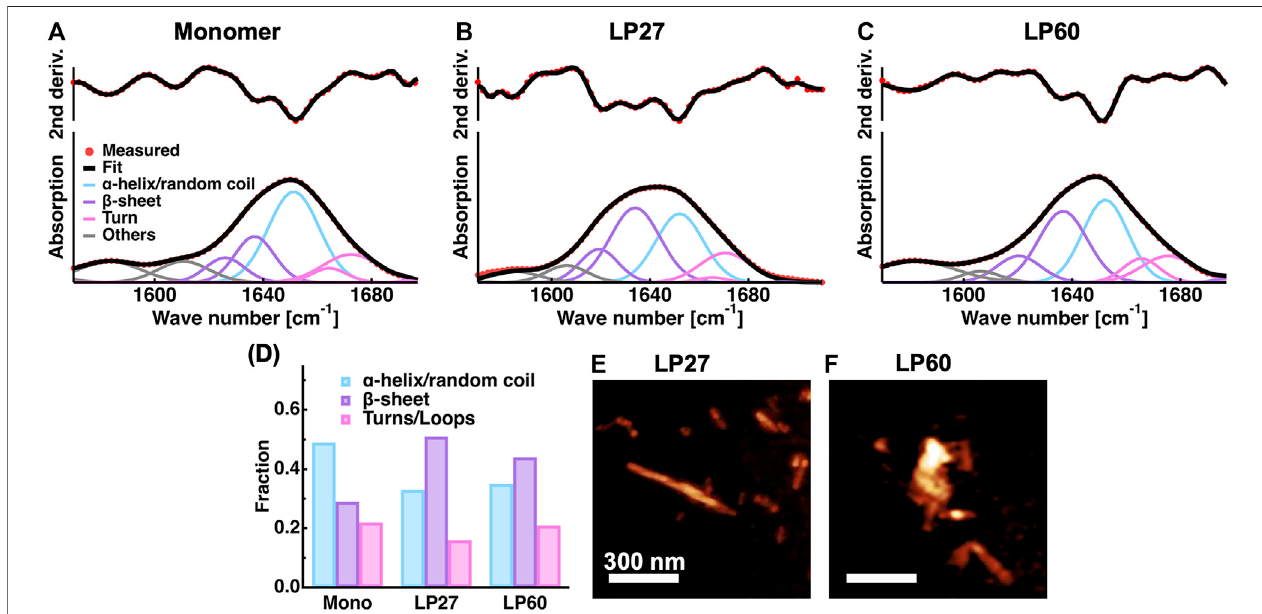
FIGURE3| Samplecharacterization. (A – C) :ATR-FTIRspectraofHEWL monomers (A) andHEWL polymorphsformed at pH2.7[LP27; (B) ] andat pH6.0 [LP60; (C) ].Thesecondderivativesofthespectraandthe fi ttingresultsarealsoshown.Red fi lledcirclesdenotetheexperimentaldatapointsandblacksolidlinesdenotethe fi ts. The solid lines in cyan, purple, magenta, and grey represent the contributions from α -helices/random coils, β -sheets, turn structures, and other contributions, respectively. (D) :Thesecondarystructurecontentofthesamplesestimatedfromthespectrashownin (A – C) . (E – F) :AFMimagesofLP27 (E) andLP60 (F) shown using the software Gwyddion (Ne č as and Klapetek, 2012). The scale bars correspond to 300